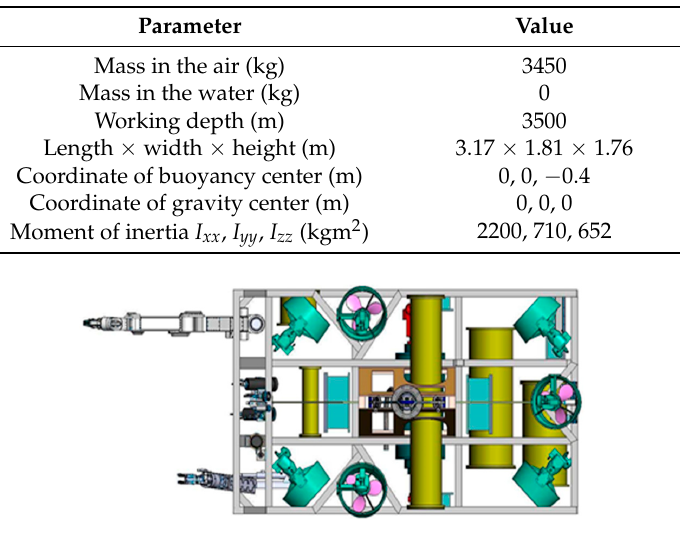
Figure 2. Thruster configuration of ROVs.